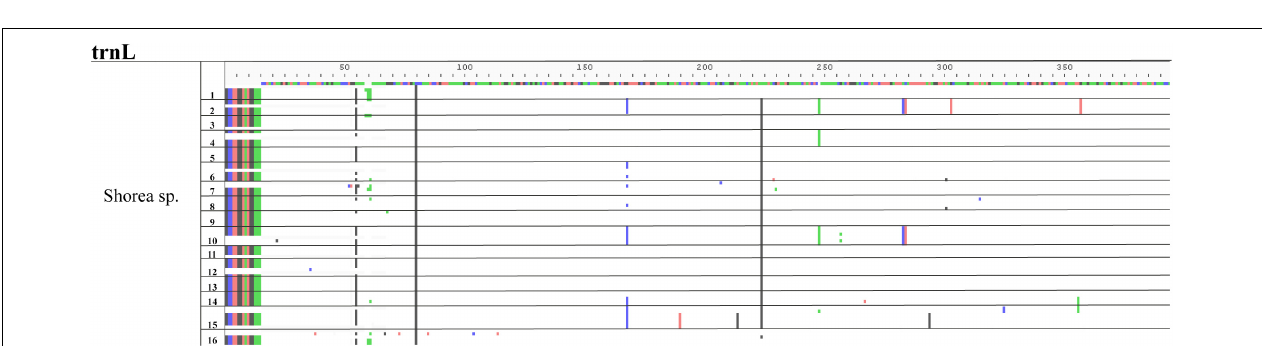
FIGURE 5 | Heatmap corresponding to the confusion matrix of assignment for problematic genera in the case of the matK marker. Species from selected genera are depicted in the same order in the x - and y -axis. Horizontal band color and vertical bar colors at the bottom and side of the heatmap correspond to the families evaluated. Squares enclose their corresponding species. Species in X -axis (original) are predicted as one of the Y -axis (predicted). The numbers within parenthesis represents the number of sequences for that species.